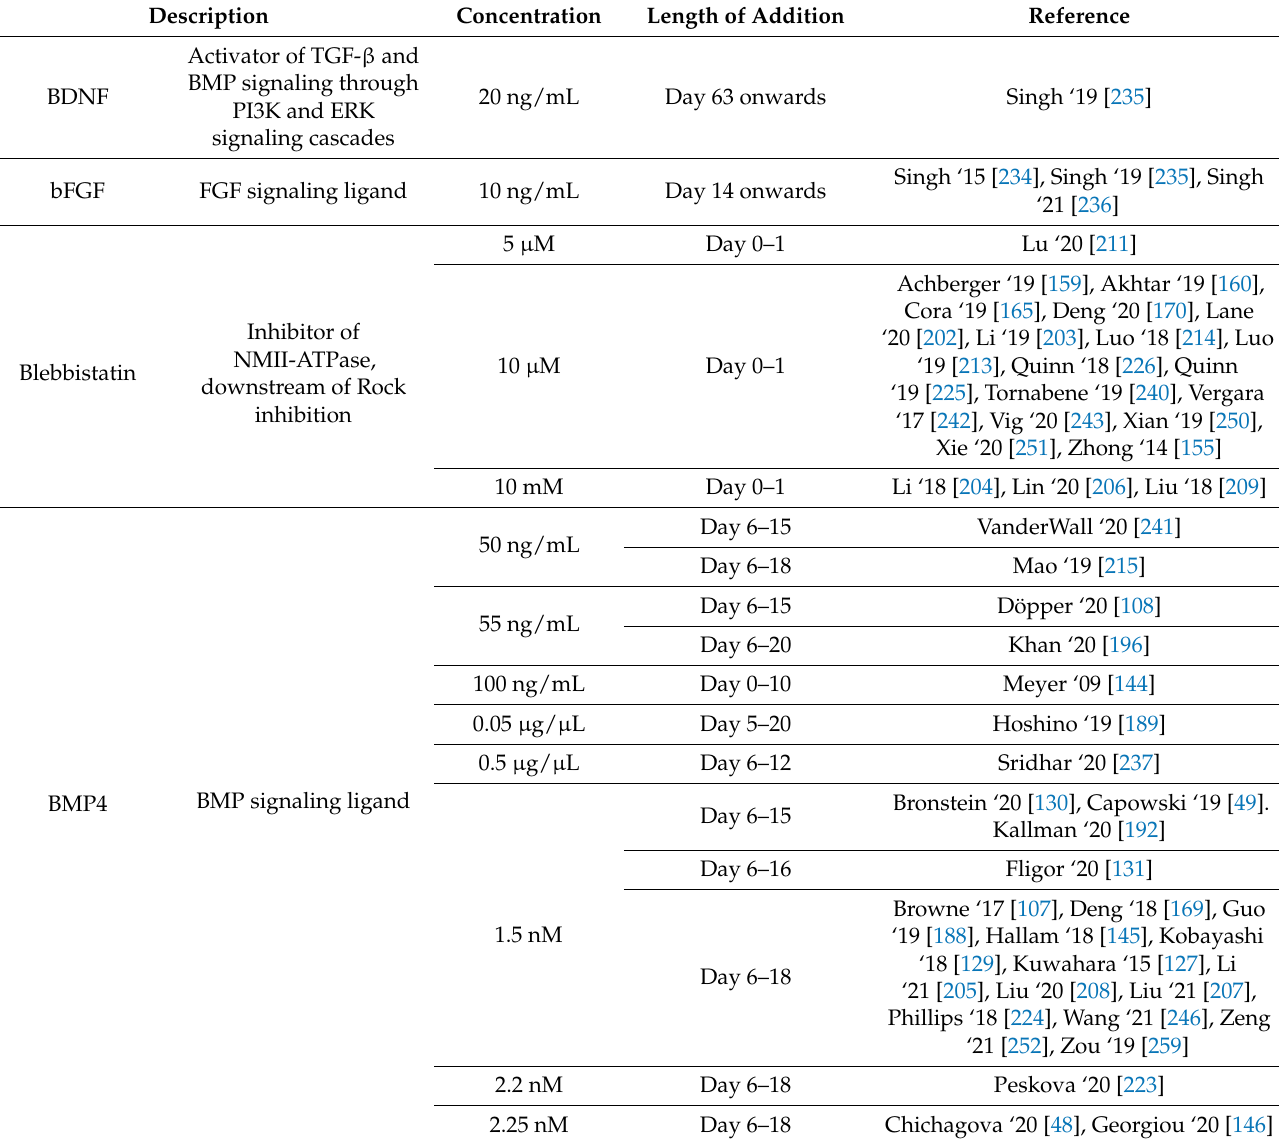
Table 1. Summary of the additions used to promote retinal differentiation in organoid protocols and their frequency, concentration, and time interval of use. Analysis of the literature uncovered many supplements that are added to regulate signaling pathways throughout the development of retinal organoids. We decided to use the conditions and concentrations highlighted with an asterisk (*) and test their effect on retinal differentiation in our organoid protocol, representing the more popular time points or concentrations used for a range of conditions affecting different signaling pathways. For further explanation of the individual additions used, see